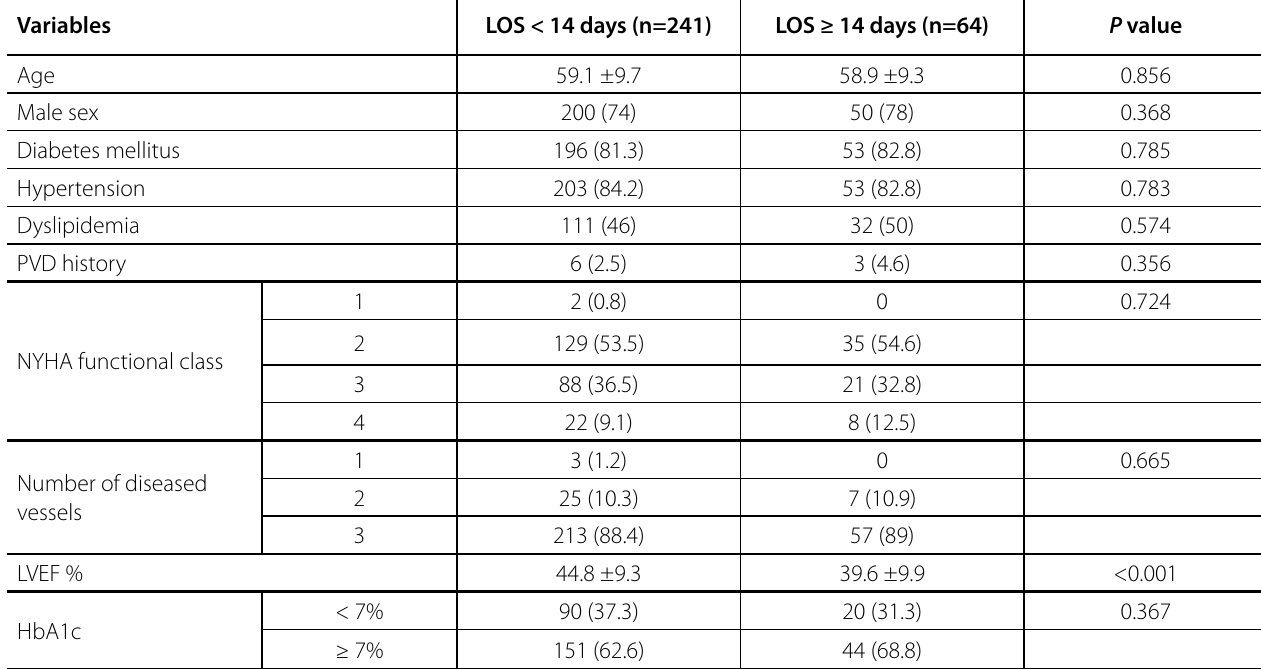
Table 4 . Predictors of length of hospital stay post coronary artery bypass graft surgery. Variables